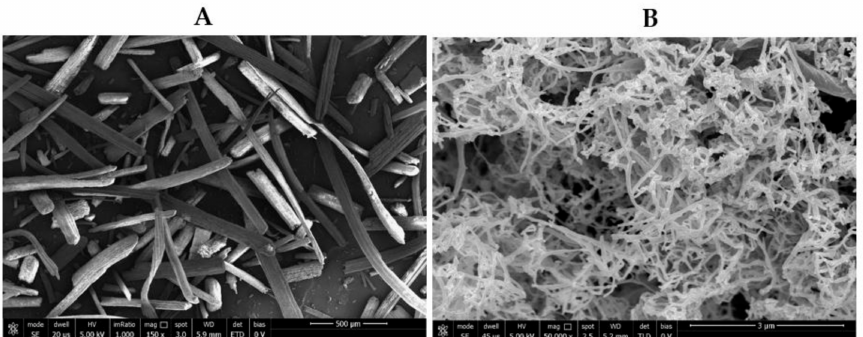
Figure 3. SEM images of both grinded egagropili fibers ( A ) and egagropili nanocrystalline cellulose ( B ).